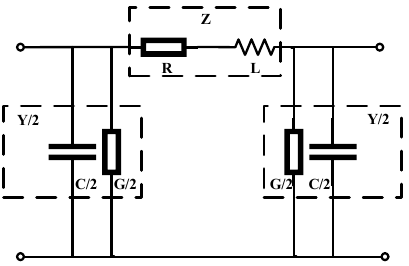
Figure 2. The π -type lumped parameter model of a submarine cable segment.